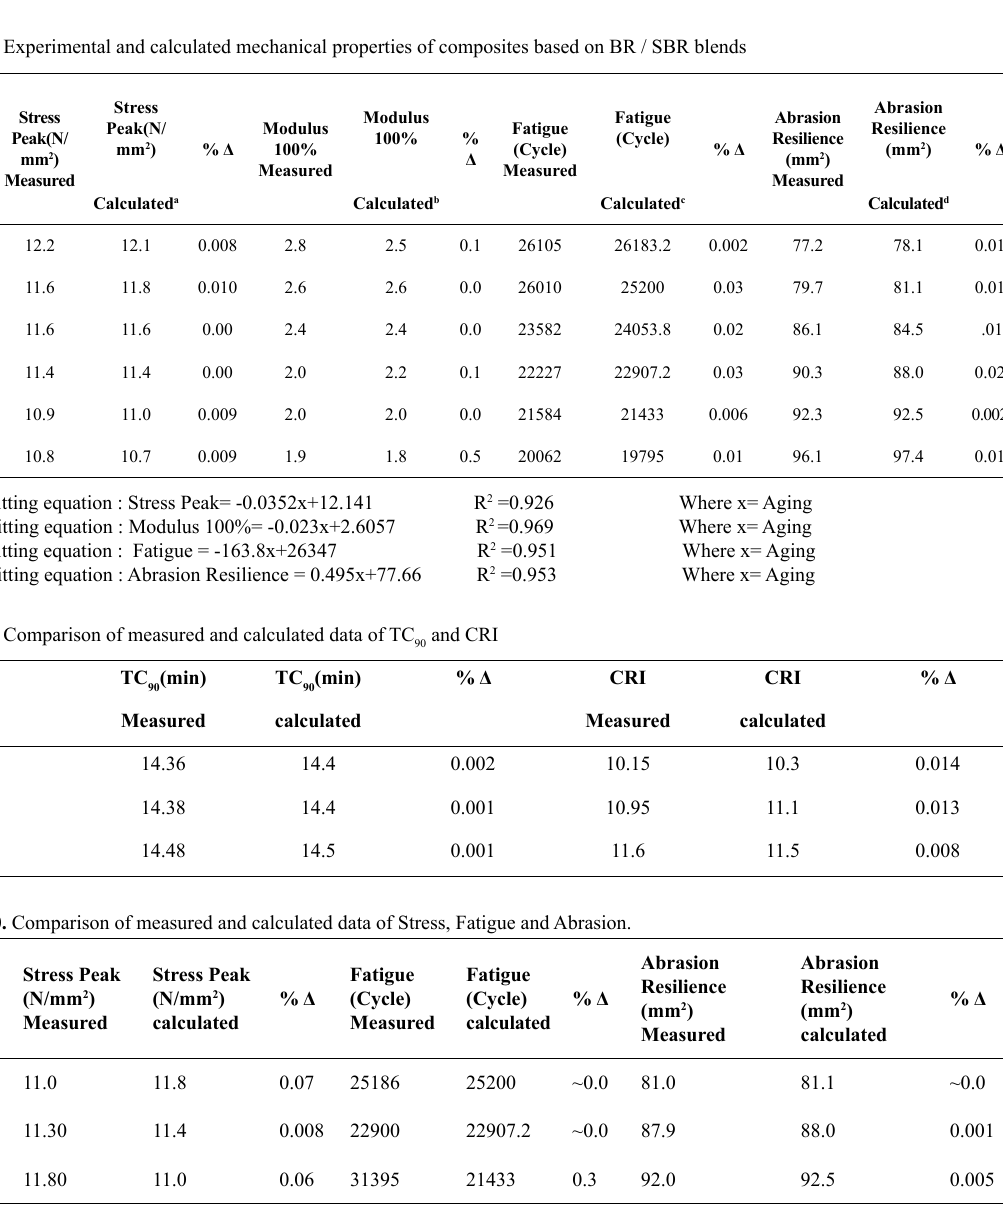
Table 8. Experimental and calculated mechanical properties of composites based on BR / SBR blends